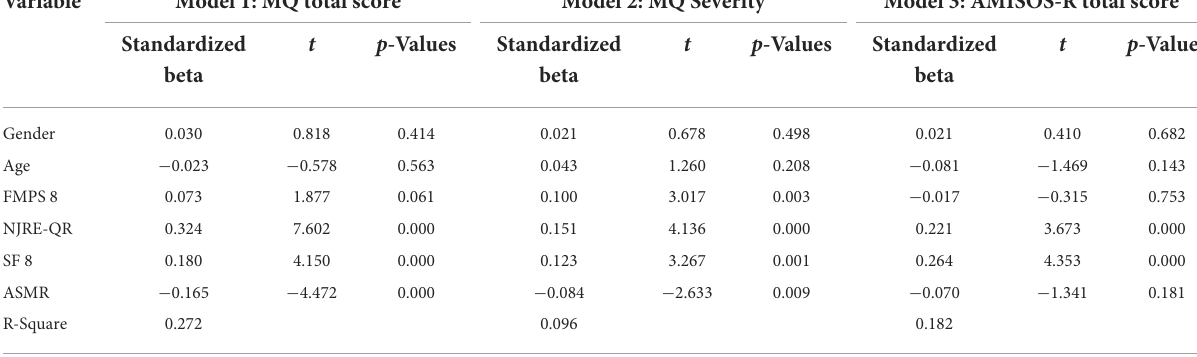
TABLE 5 Predictors of MQ total score and MQ Severity in multiple linear regression models.